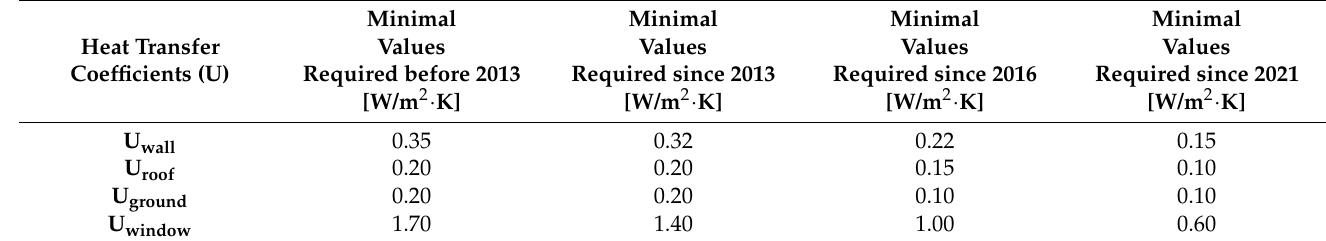
Table 4. Difference between minimal required values of heat transfer before 2013 and since 2021 corresponding to the Nearly Zero Energy Buildings concept implemented in Slovakia by the National Standardisation STN 73